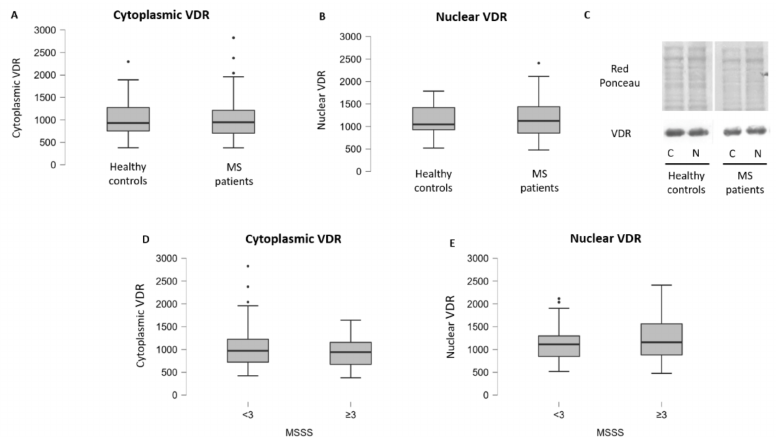
Figure 3. ( A ) Cytoplasmic and ( B ) nuclear VDR protein expression in MS patients and healthy controls; 25th percentile, median and 75th percentile are reported on the dot plot (black bars). No statistically significantly difference between MS patients and healthy controls was observed (Mann–Whitney test, p > 0.05). ( C ) Representative Western blot images of VDR protein content in PBMCs from MS patients and controls subdivided in cytoplasmic (C) and nuclear (N) fractions. Red ponceau was used to normalize the data. ( D ) Cytoplasmic and ( E ) nuclear VDR protein expression in patients with a mild form (MSSS score < 3) and with moderate to severe forms (MSSS ≥ 3) of MS; 25th percentile, median and 75th percentile are reported on the dot plot (black bars). No statistically significant differences were observed in total, cytoplasmic and nuclear protein levels (Mann–Whitney test, p > 0.05).